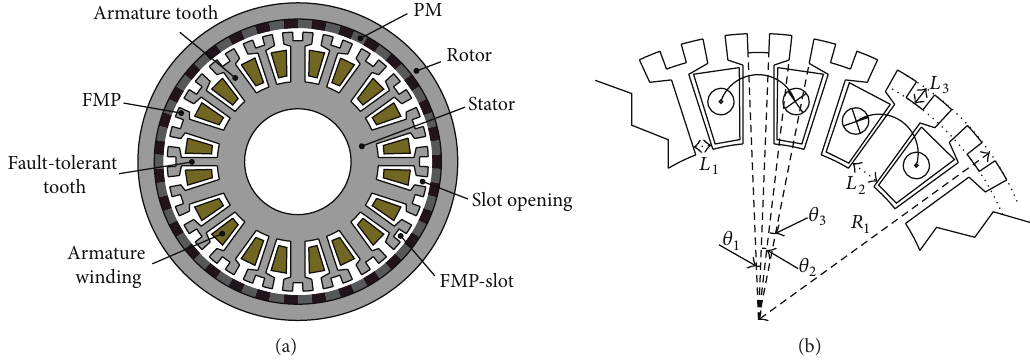
Figure 11: Proposed FT-PMV machine. (a) Cross section. (b) Parameters.